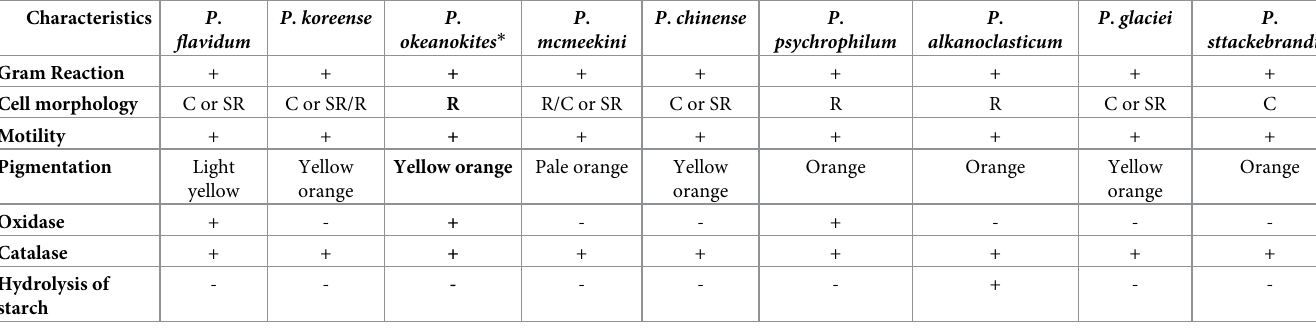
Table 2. Differential phenotypic characteristics of various Planomicrobium